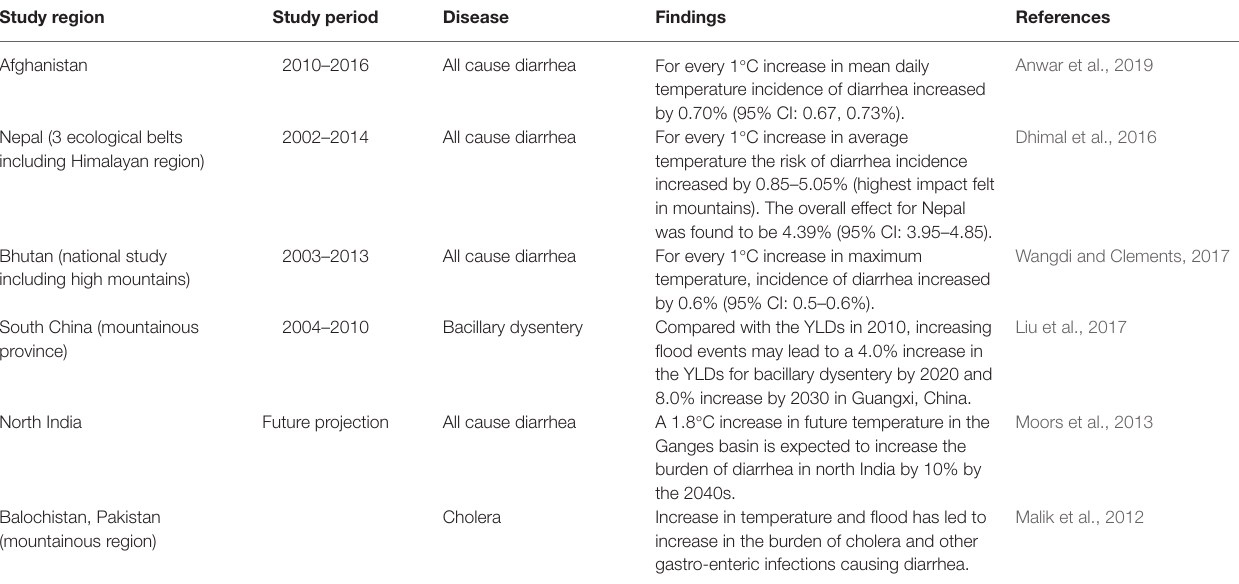
TABLE 2 | Epidemiological evidence on the impacts of climate change on food- and water-borne diarrhea in HKH